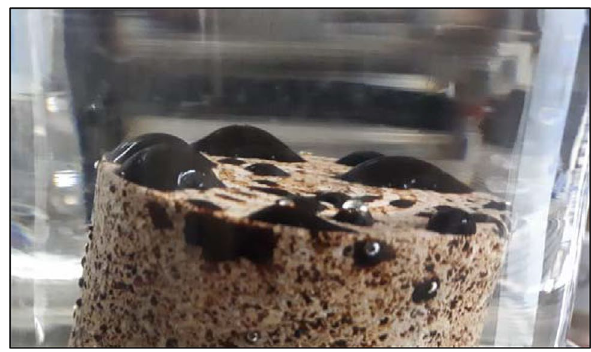
Fig. 10 Oil expulsion during spontaneous imbibition